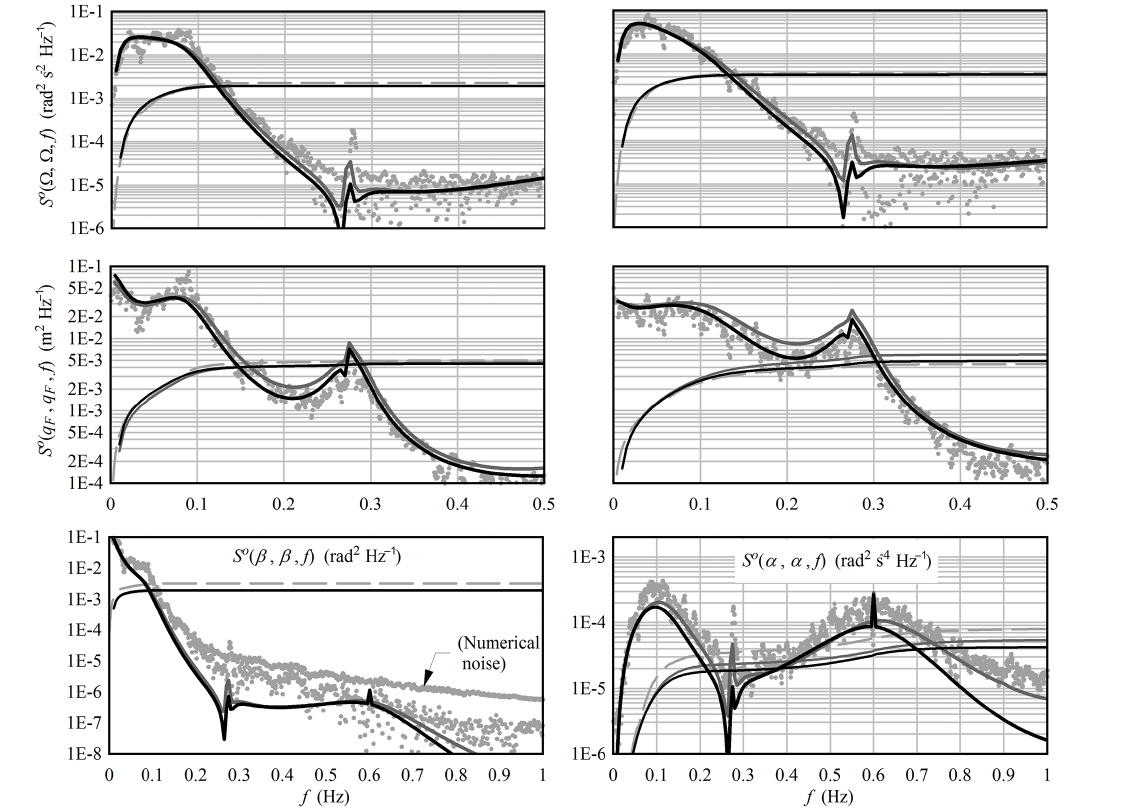
Figure 16. The results of Fig. 16, repeated with I = 0.16. On the left: mean wind speed of 16ms − 1 ; on the right: 20ms − 1 . The figure in the lower left is the spectrum of blade pitch angle; the spectrum of pitch acceleration is meaningless, due to the abrupt saturation of the pitch angle at 0 ◦ .